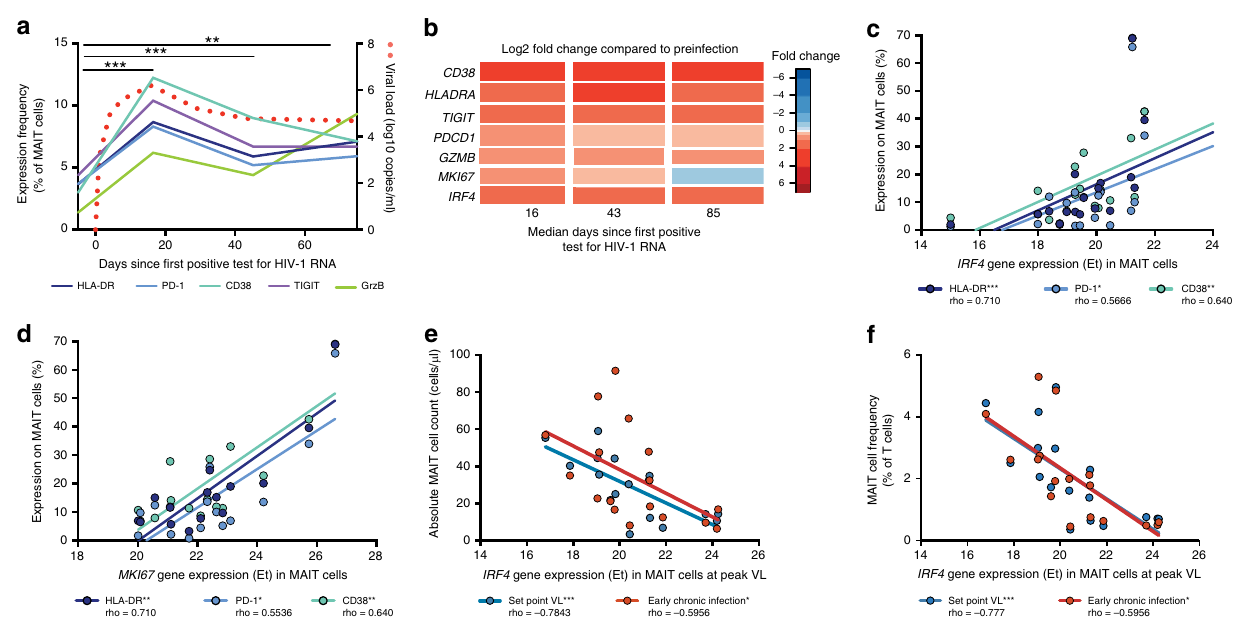
Fig. 2 MAIT cell activation in acute HIV-1 infection. a Median expression of markers of activation and exhaustion (HLA-DR, PD-1, CD38, TIGIT, and GrzB) in MAIT cells in PBMC as assessed by fl ow cytometry displayed over time in acute HIV-1 infection ( n = 19). b The fold change of gene expression compared to pre-infection of individual genes ( CD38 , HLADRA , TIGIT , PDCD1 , GZMB , MKI67 , and IRF4 ) in three post-infection time points in acute HIV-1 infection from bulk sorted MAIT cells ( n = 20). c Correlation of IRF4 and d , MKI67 gene expression in bulk sorted MAIT cells with the protein expression of markers activation (HLA-DR, PD-1, and CD38) at the post-infection time point corresponding with peak VL (median 16 days since fi rst positive test for HIV-1 RNA) ( n = 20). e Correlation of gene expression of IRF4 in sorted MAIT cells with MAIT cell absolute counts, or f , MAIT cell frequency at two post- infection time points corresponding with set point VL (median 43 days since fi rst positive test for HIV) or early chronic infection ( n = 20). * p ≤ 0.05, ** p ≤ 0.01, *** p ≤ 0.001. In a , statistical analysis was performed using the nonparametric Friedman test with the Dunn ’ s multiple comparison test; in c , d , e , and f correlative analyses were performed using Spearman Rank correlation test. In a , signi fi cance indicated is valid for all markers displayed. PBMC, Peripheral blood mononuclear cells. MAIT cells are identi fi ed as CD161 + + V α 7.2 + within CD3 + CD14-CD19- live lymphocytes. VL viral load. The source data underlying a and b are provided as a Source Data fi